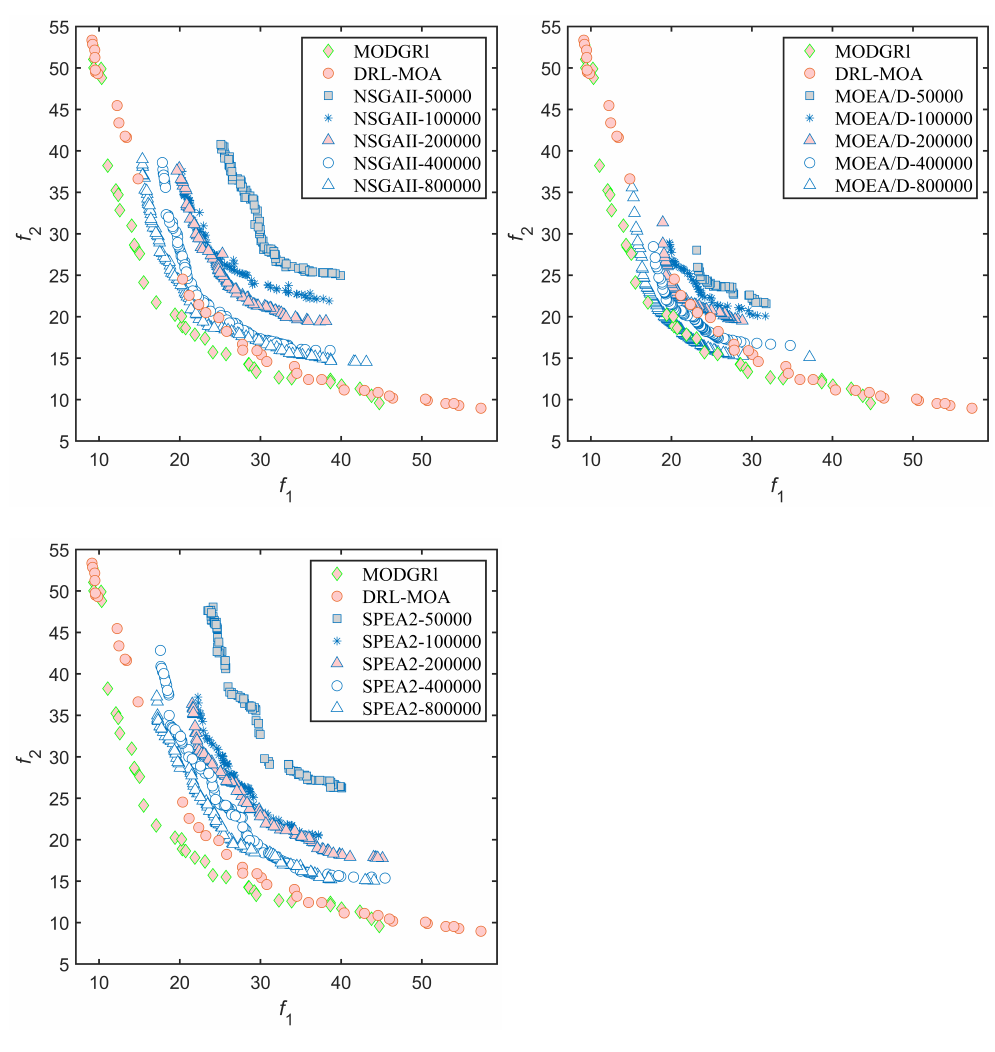
Figure 2. The Pareto-frontiers of MODGRL, DRL-MOA, NSGA-II, MOEA/D and SPEA2 algorithms on the KroAB 100